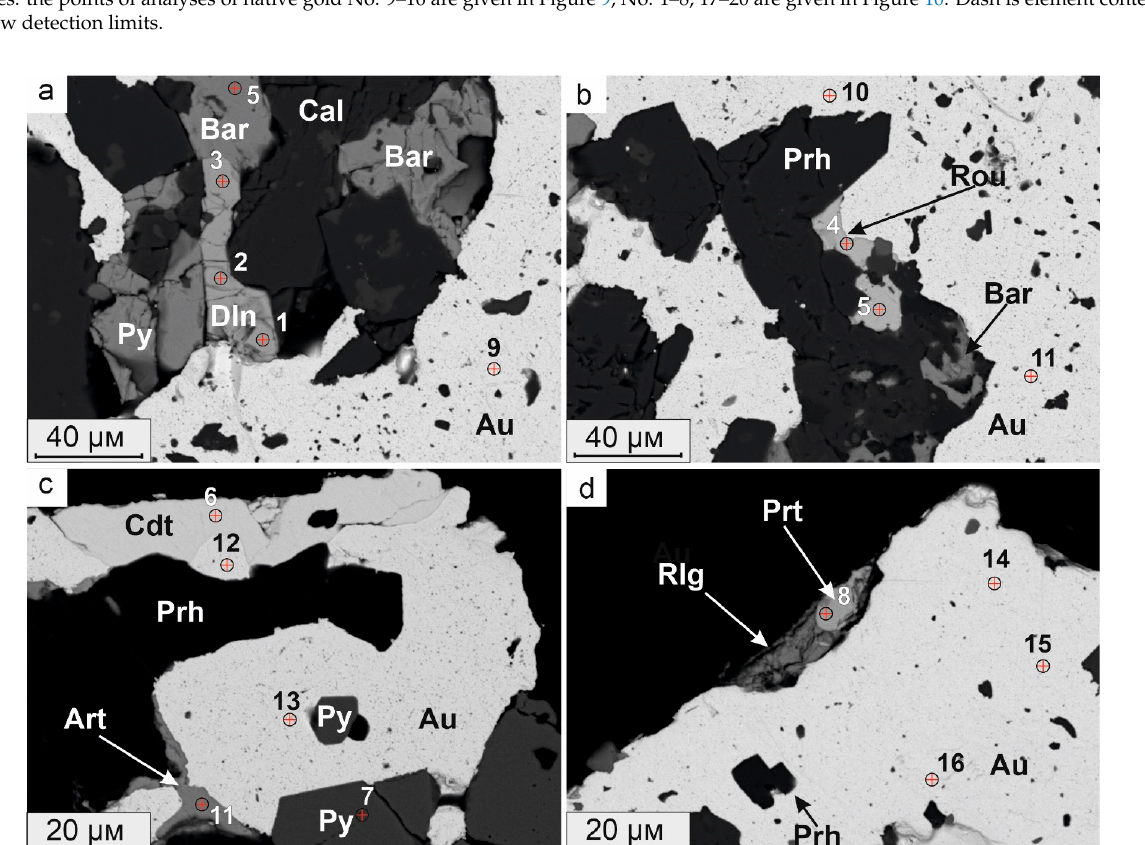
Empirical Formulae Fineness